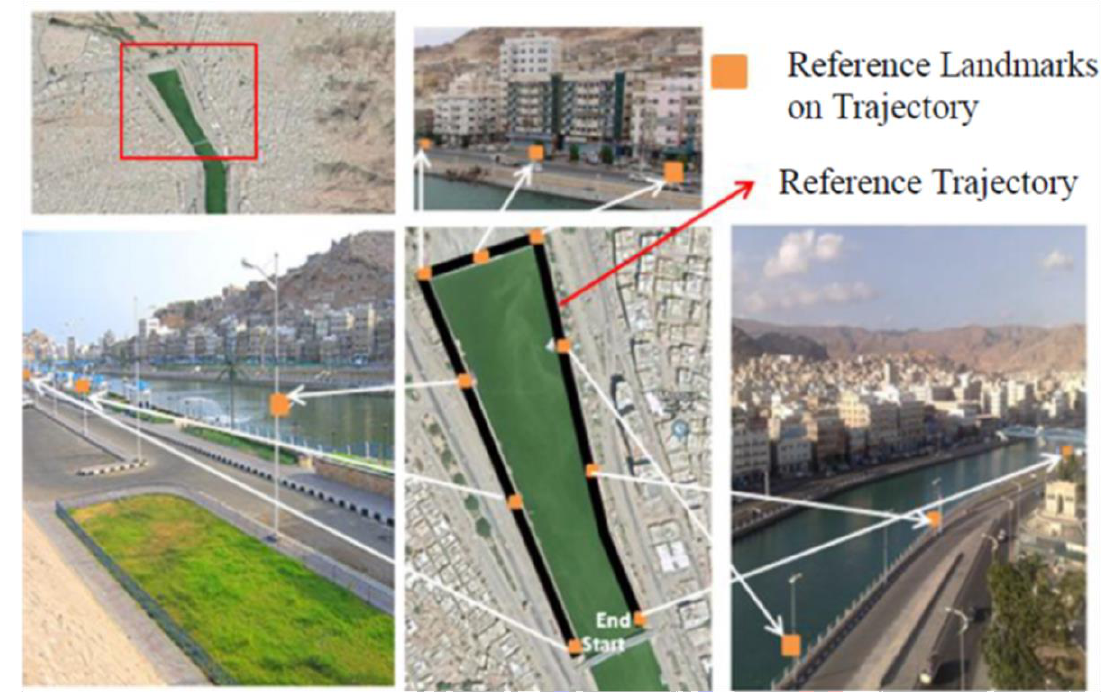
Figure 7. Description of hardware used: ( a ) hardware components, ( b ) hardware connection system, ( c ) hardware setup on vehicle.